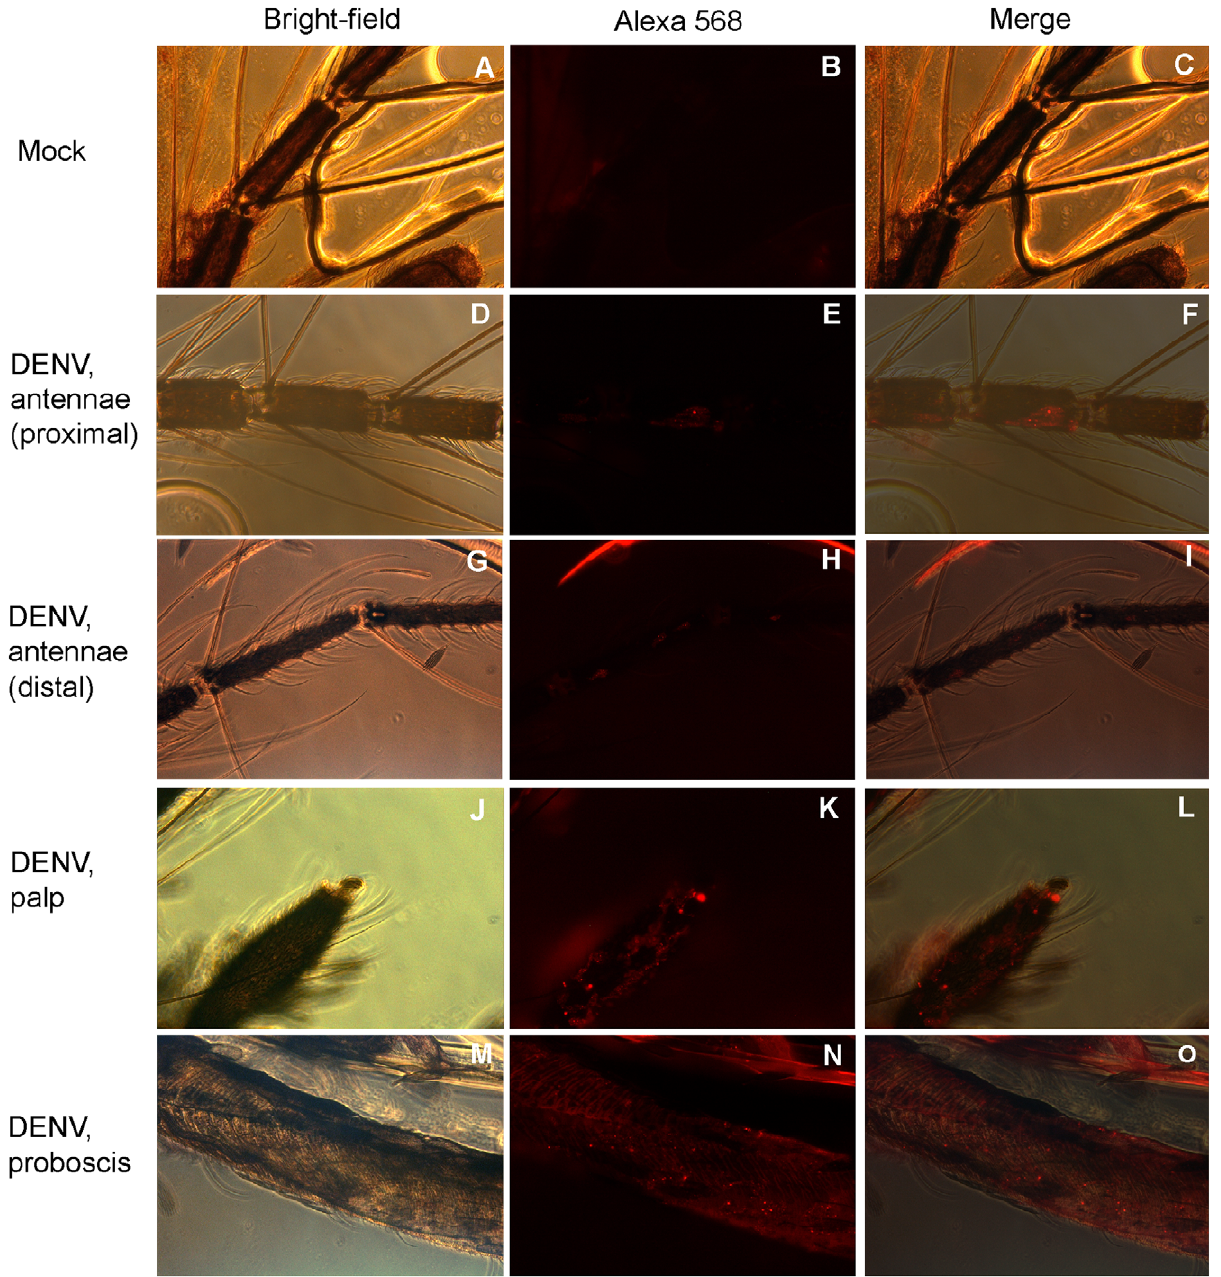
Figure 5. Detection of DENV infection in the chemosensory organs by immunofluorescence staining. Head squashes from mosquitoes at 14 dpbm were stained with mouse hyperimmune ascitic fluid to DENV and an AlexaFluor568-conjugated anti-mouse antibody. ( A–C ) Uninfected antennae, ( D–F ) Infected antennae at segments 2–4, ( G–I ) Infected antennae at segments 9–11, ( J–L ) Infected maxillary palp, ( M–O ) Infected proboscis. Red, DENV